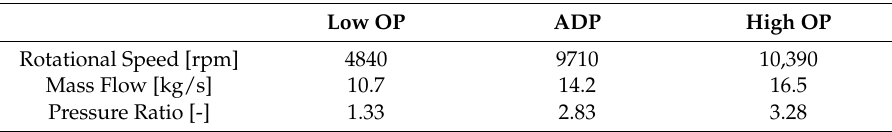
Table 1. Operating Conditions of the Three Different Operating